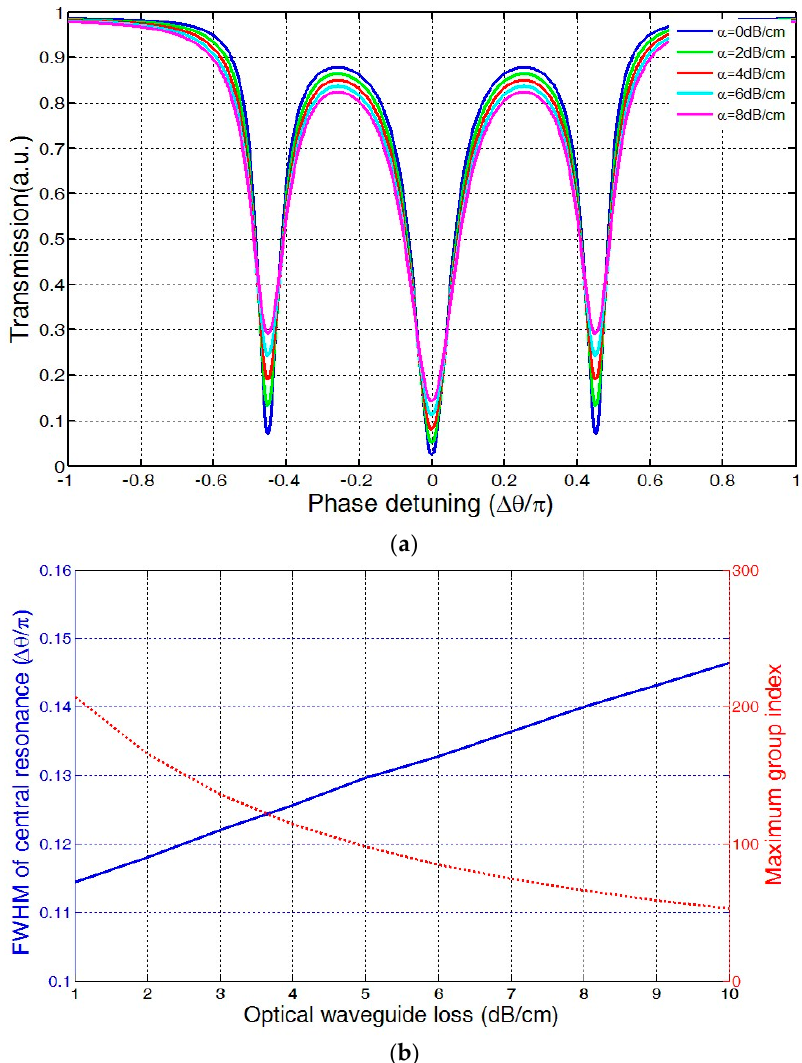
Figure 4. Effect of waveguide loss: ( a ) on transmission spectrum ( b ) on FWHM of central resonance and maximum group index.